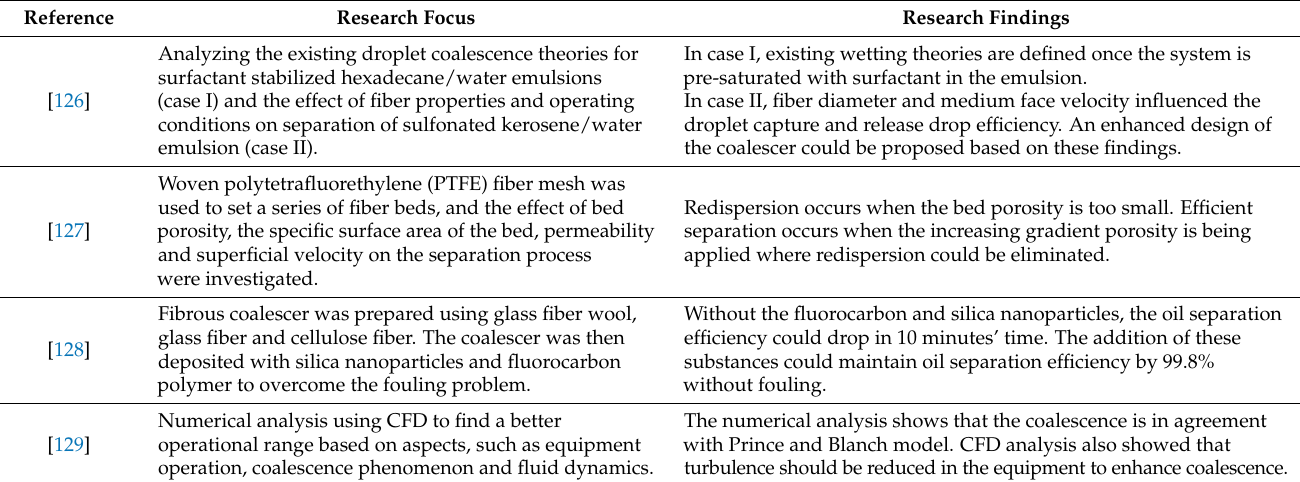
Table 5. Recent development in oily wastewater treatment system using mechanical methods from 2018 to present.